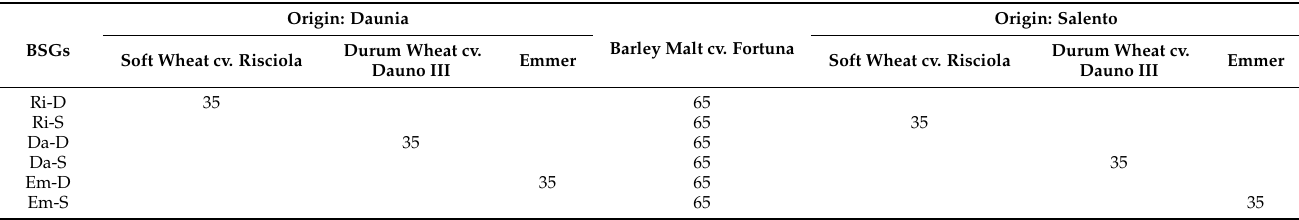
Table 1. BSG composition (%) and geographical